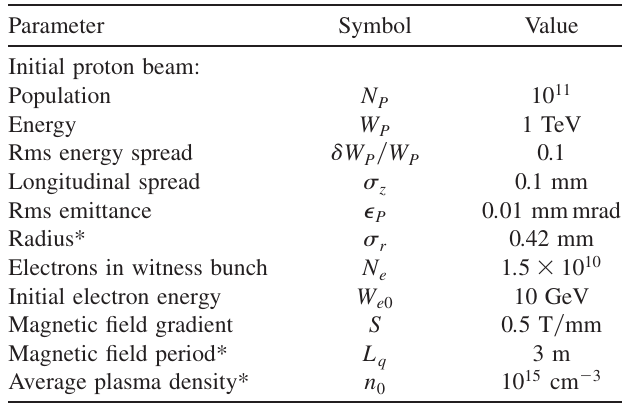
TABLE I. Basic set of beam and plasma parameters. Marked by asterisks are the values obtained from calculations (see the